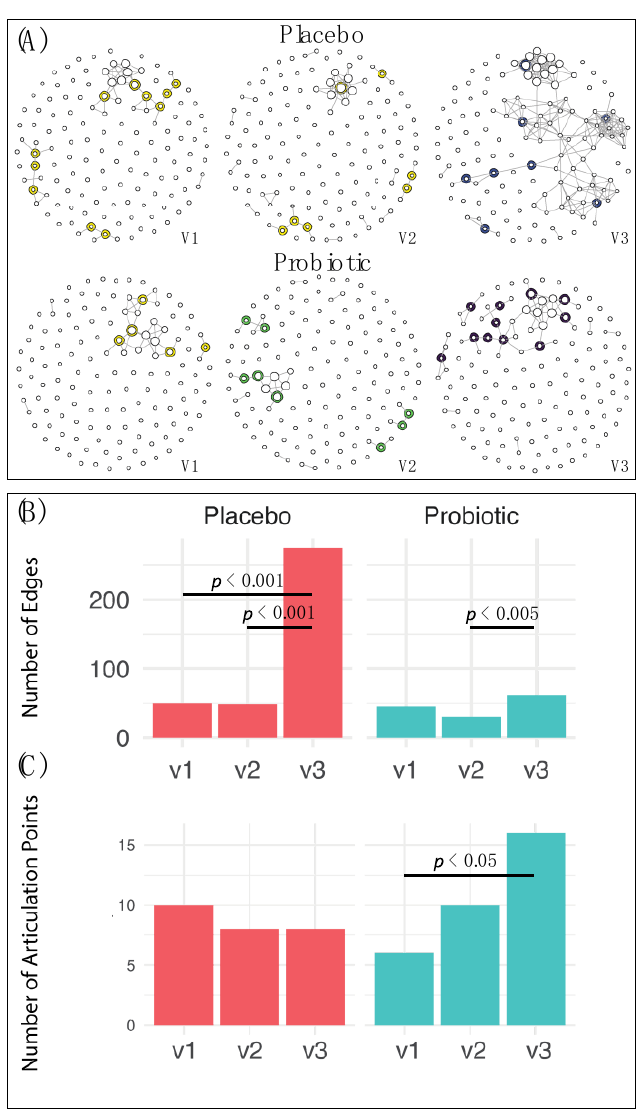
Figure 3. SparCC network associations between genus-level gut microbiota between subjects receiving placebo and those receiving the active probiotic overtime, using a SparCC cutoff of 0.7. Placebo group V1 is baseline, V2 is after placebo, V3 is after placebo added OXT; probiotics group V1 is baseline, V2 is after probiotics, V3 is after probiotics added OXT. ( A ) SparCC co-occurrence network. Articulation points are marked as halos around the node. Hub score is indicated by the size of the node. ( B ) The number of lines or edges is significantly enriched in both the OXT alone and combination groups at visit 3 (Pearson’s χ 2 -test with Yates’ continuity correction, p < 0.005). ( C ) The number of articulation points is only significantly increased in the combination group at V3 compared to baseline number of articulation points (Pearson’s χ 2 -test with Yates’ continuity correction, p < 0.05).